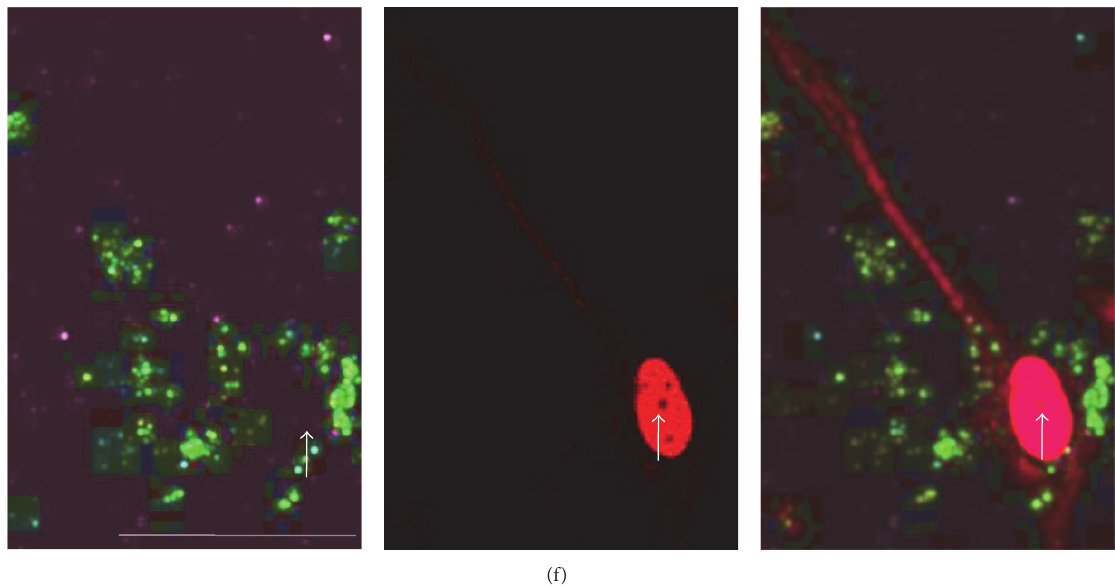
Figure 5: Importazole blocks importin 𝛽 -mediated nuclear import in hippocampal cells. (a) Control cells expressing NFAT-GFP were treated with ionomycin to induce nuclear import of NFAT-GFP. NFAT-GFP localizes within nucleus (Hoechst, arrows) and surrounding regions (overlay, arrows). Inset is expanded for more clear visualization. (b) Cells expressing NFAT-GFP were treated with 18 𝜇 M importazole prior to treatment with ionomycin, and nuclear localization was compared to controls in the presence of ionomycin (quantified in c). NFAT- GFP is excluded from nucleus (Hoechst, arrows) but retains extranuclear localization (overlay, arrows). Inset is expanded for more clear visualization. (c) Percentage of cells with nuclear NFAT-GFP. 150 or more cells were counted under each condition. Student’s t -test with Bonferroni’s correction ∗ 𝑝 < 0.01 . (d–e) Live/dead assay of either (d) control or (e) IPZ treated cells treated with ionomycin after transfection shows no toxicity (red) and high viability (green) in both control and treated cells. (f) Given the possibility that only nonneuronal cells were affected by IPZ, we tested whether cells expressing NFAT-GFP were immunolabeled with the axonal marker (SMI-31, red) after IPZ treatment. SMI-31 positive cells indeed expressed NFAT-GFP, thus indicating that neuronal cells were capable of being affected by IPZ treatment. NFAT- GFP signal is observed in the proximal axons. Arrows indicate absence of GFP signal within the nucleus. SMI-31 also cross-reacts with nuclear intermediatefilaments,thusresultinginred-labelednuclei.GFPimageshavebeencontrast-enhancedforvisualizationpurposes.Baris50 𝜇 m. Values represent mean ±